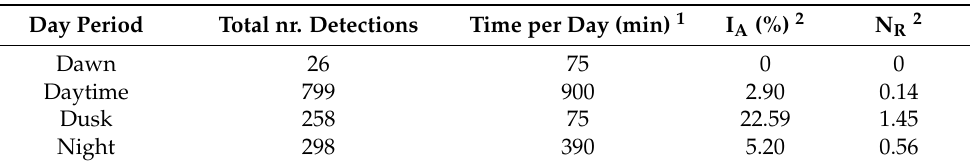
Table 3. General data on the activity and short-distance ranging movements of dusky groupers in the Pessegueiro island and Martinhal Islets study areas.